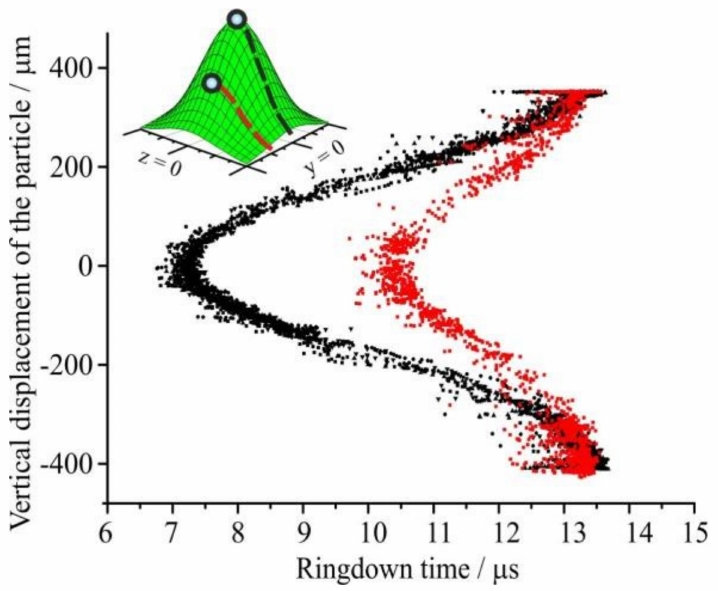
Figure 4. Sensitivity of the measured RDT to the position of a 1 µ m radius particle within the CRDS beam. The change in RDT time with vertical position is recorded for a particle passing through the center of the beam (black symbols) and ~200 µ m off-center (red symbols) (reprinted with permission from [137]. Copyright (2013) American Chemical